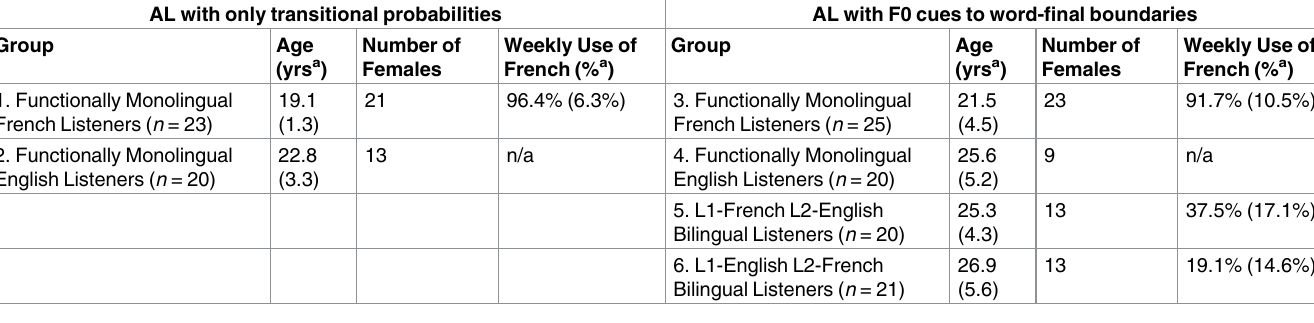
Table 1. Participants’ biographical information and experimental condition.